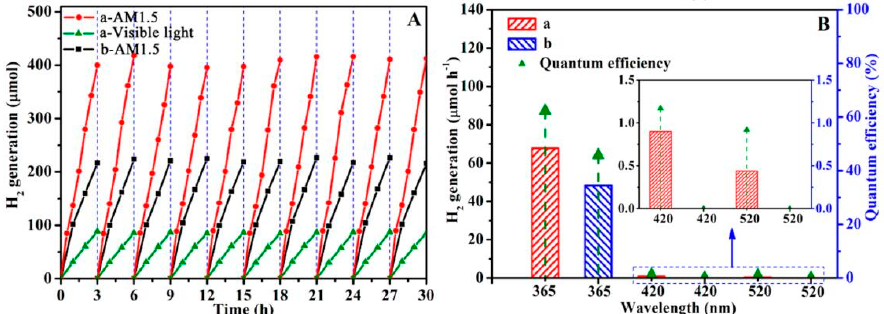
Figure 22. Photocatalytic hydrogen evolution of ordered mesoporous black TiO 2 (a) and pristine ordered mesoporous TiO 2 materials (b). ( A ) Cycling tests of photocatalytic hydrogen generation under AM 1.5 and visible light irradiation. ( B ) The photocatalytic hydrogen evolution rates under single-wavelength light and the corresponding QE. The inset enlarges the QE of single-wavelength light at 420 and 520 nm [133]. Copyright 2014 American Chemical Society.